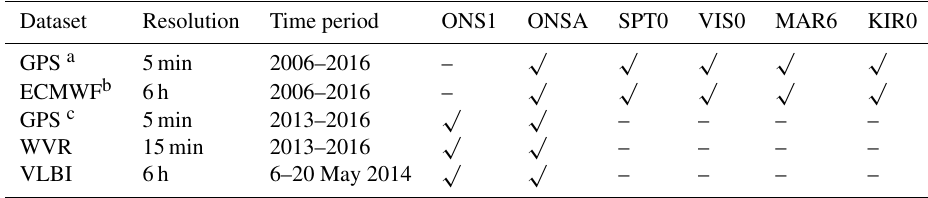
Table 3. Summary of used datasets. Dataset